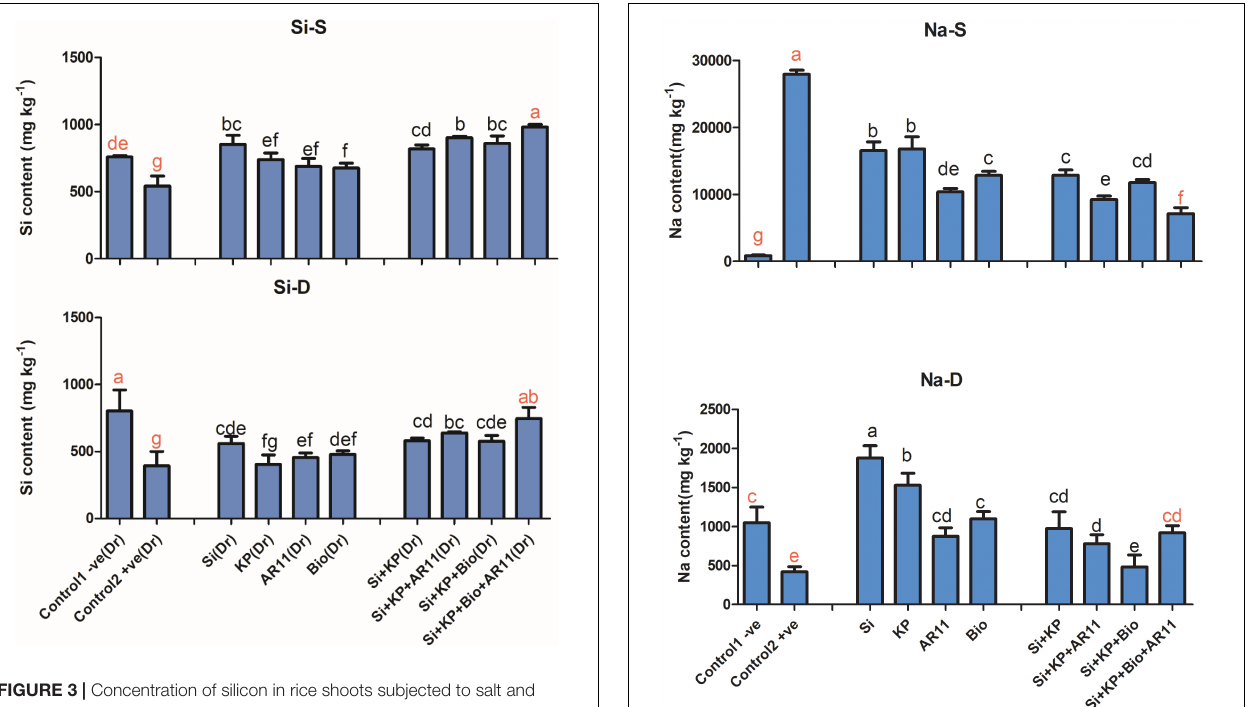
FIGURE 3 | Concentration of silicon in rice shoots subjected to salt and drought stresses following AR11, Si, K 2 HPO 4 , and biochar inoculation. (-S), salt; (-D), drought. Error bars represent standard deviations. Each data point represents the mean of at least three replications. Bars with different letters are significantly different from each other at P ≤ 0.05.